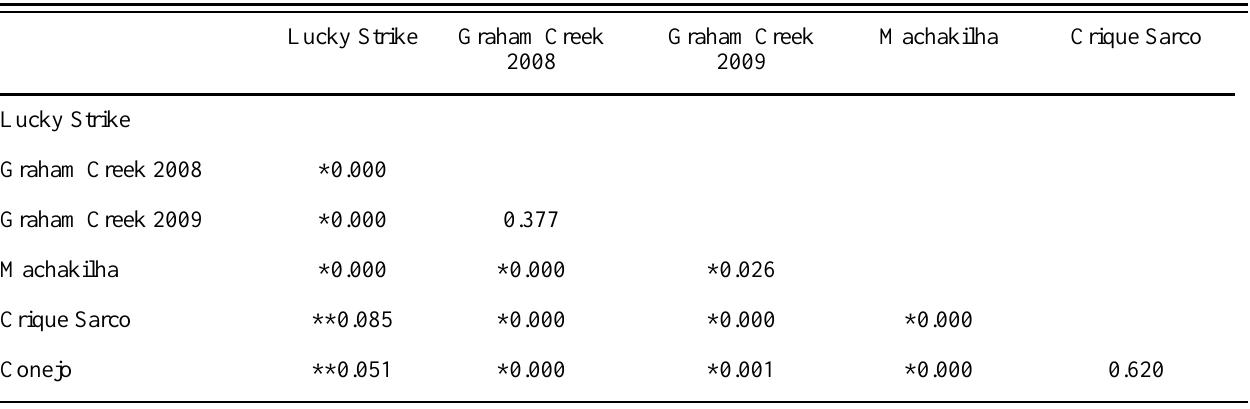
Table 2. ANOVA post hoc multiple-comparisons analysis of field sizes showing the significance of between-village